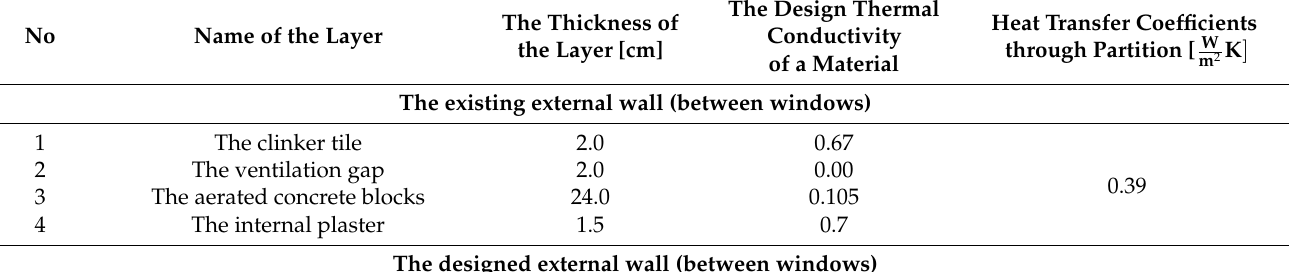
Table 2. The thermal modernisation building solutions for the residential buildings at Grunwaldzki square (elaborated by the Authors based on